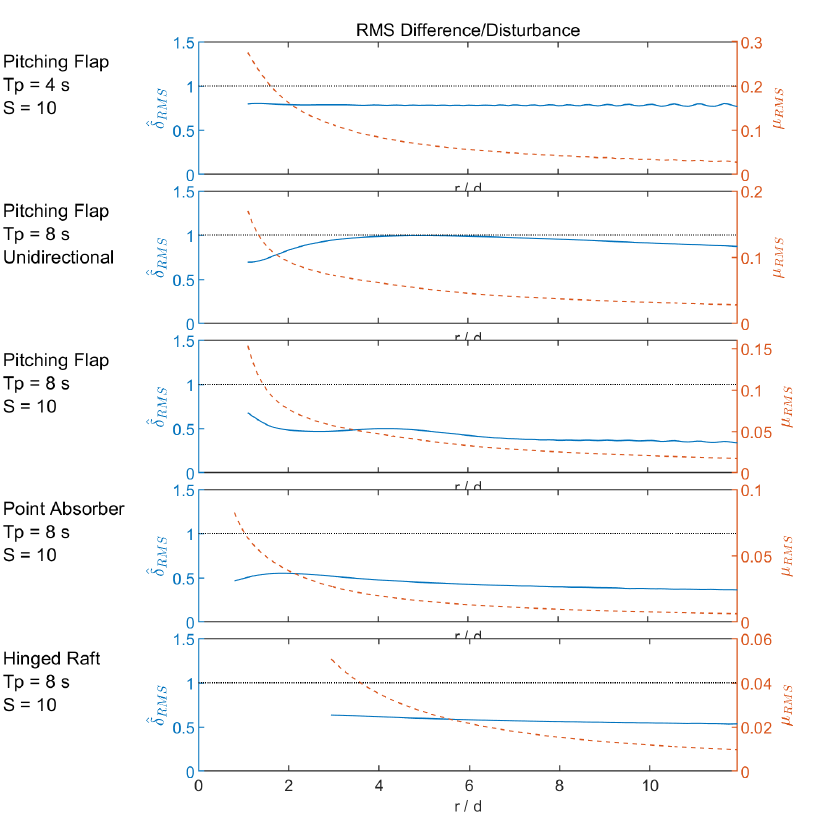
Figure 6. Single WEC RMS difference/disturbance: Normalized RMS difference, RMS disturbance, and plot of values over concentric circles as a function of radial